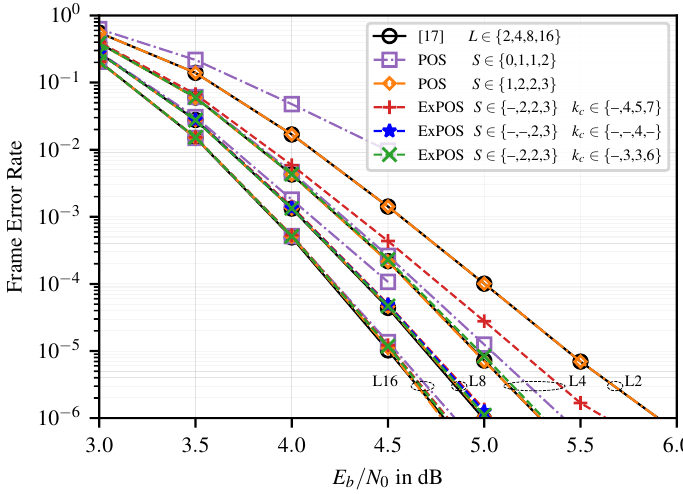
Figure 11. Error-correction performance of Polar code N = 1024, R =